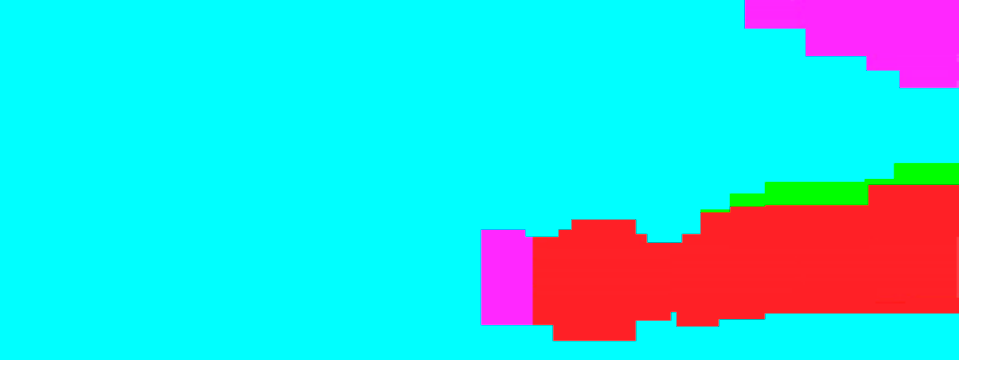
Figure 23. Asymmetrical index estimation distribution for sand